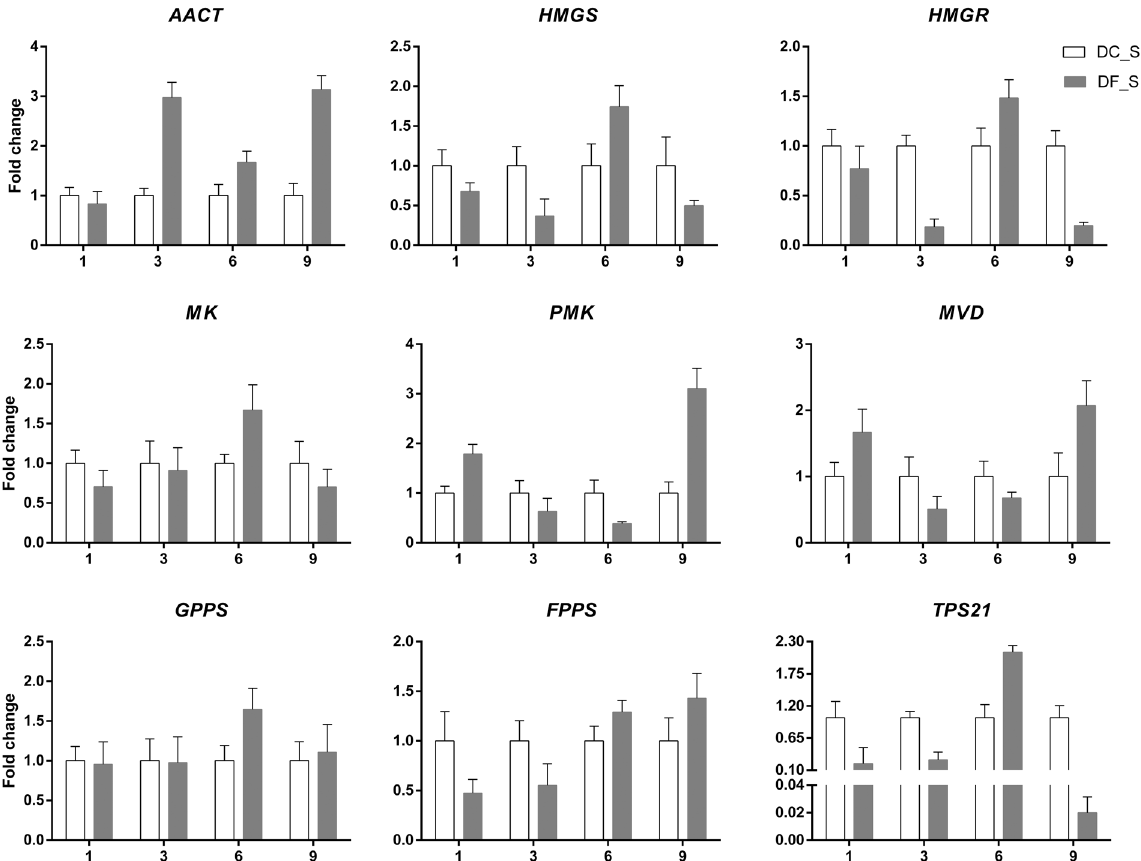
Figure 10. qRT-PCR analysis of key enzyme-coding genes involved in the MVA pathway in D. nobile . The y-axes correspond to the mean fold changes in expression values, and the x-axes display the times of symbiotic culture (/weeks). White bars represent the control group (DC_S), and grey bars represent the model group (DF_S). For each qRT-PCR validation, three technical replicates were used, with a minimum of three biological replicates.